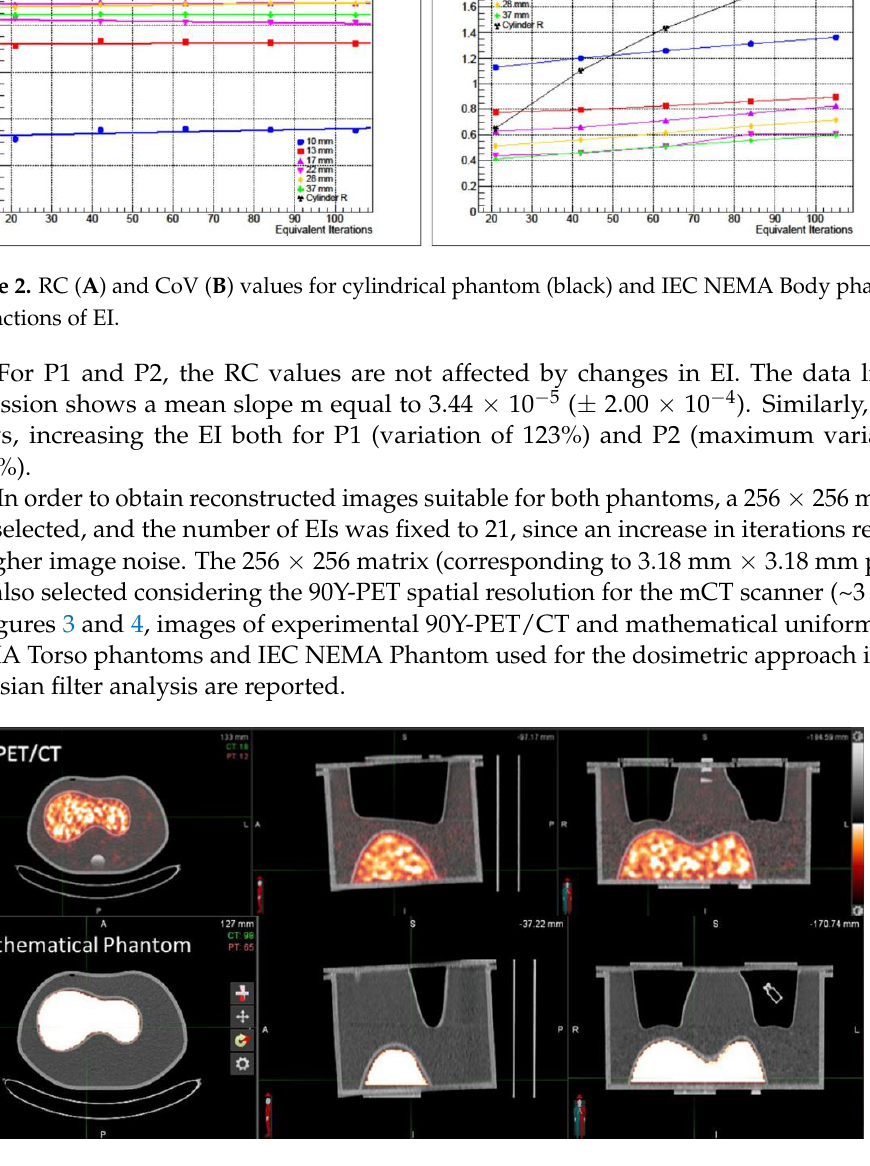
Figure 3. Experimental 90Y  PET/CT and mathematical uniform IEC NEMA Torso phantoms. Figure 3. Experimental 90Y − PET/CT and mathematical uniform IEC NEMA Torso